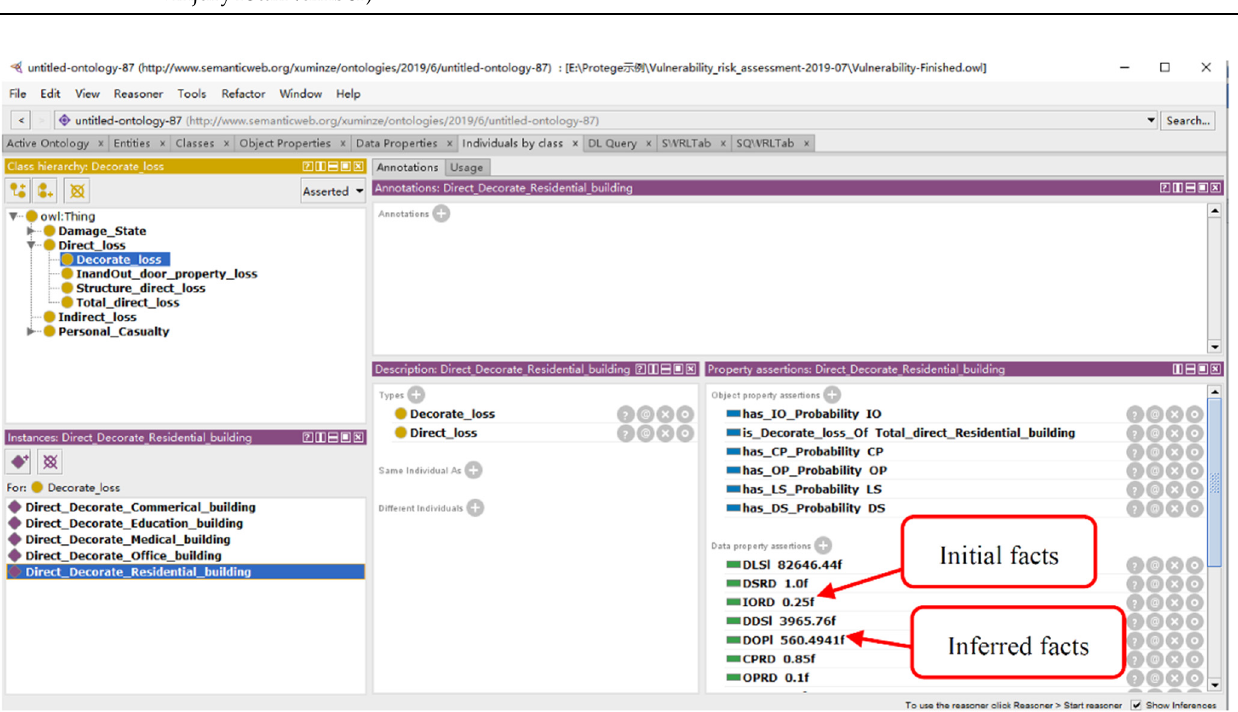
Figure 12. Inferred facts.